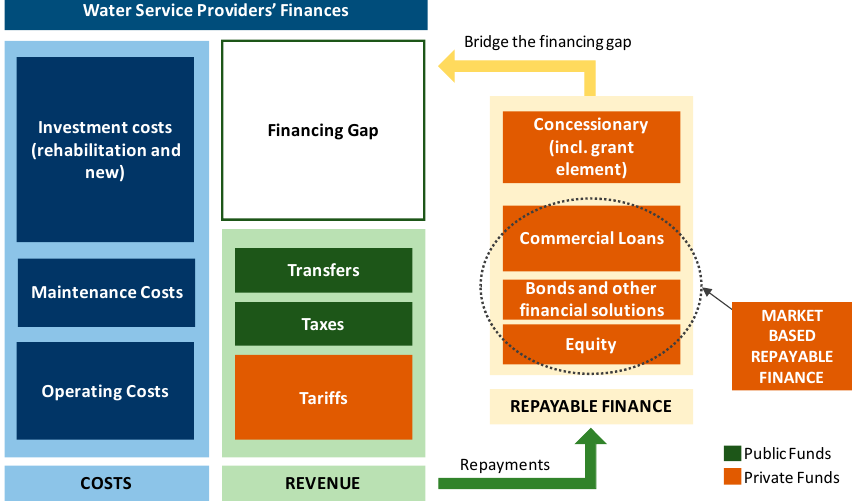
Figure 7. Water utilities’ financing (adapted from [6]).